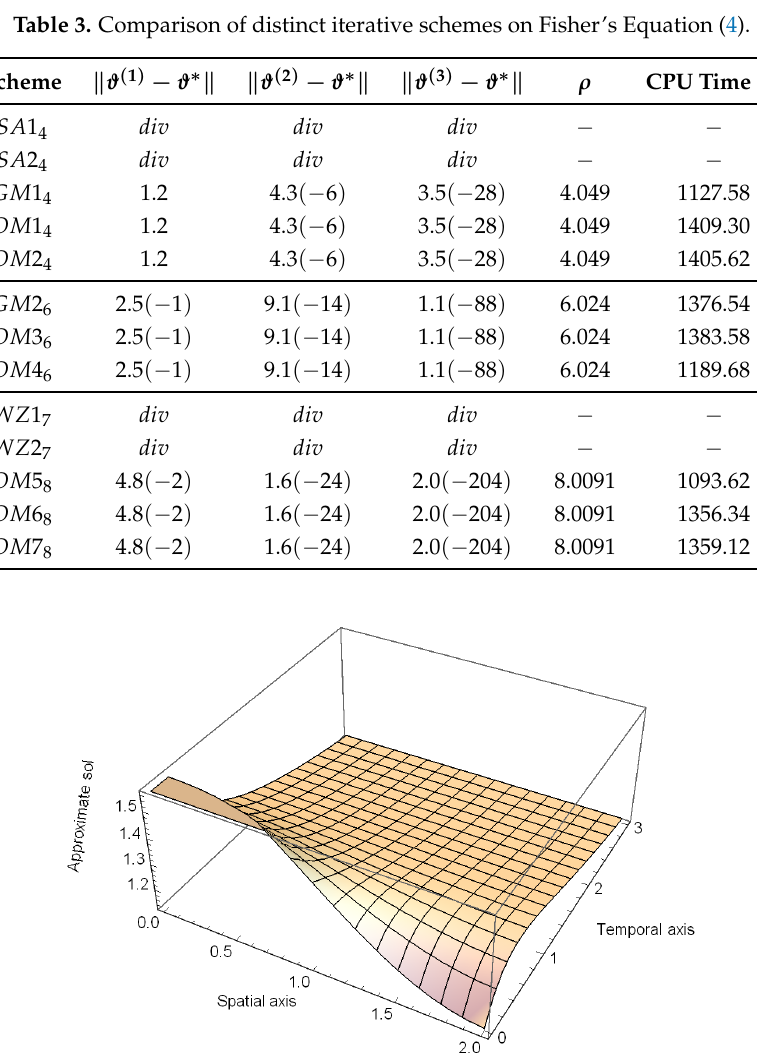
Figure 3. Approximated Solution for Fisher’s equation t ∈ [ 0,1 ]